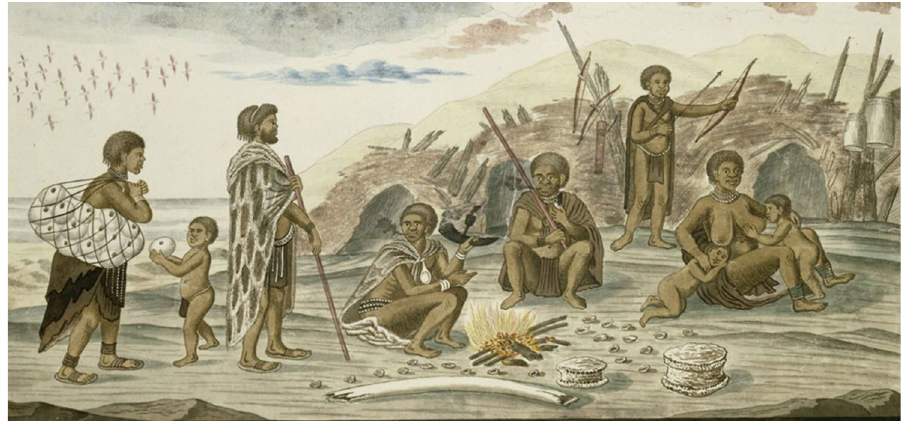
Figure 5. ‘ Homestead of the so-called Strandlopers (San or Khoikhoi) just north of the Orange River’s mouth ’, showing the roasting of what appears to be shellfish over the fire. Attributed to Robert Jacob Gordon, 1779. Adapted from https:// www. rijks museum. nl/ nl/ colle ctie/ RP-T- 1914- 17-